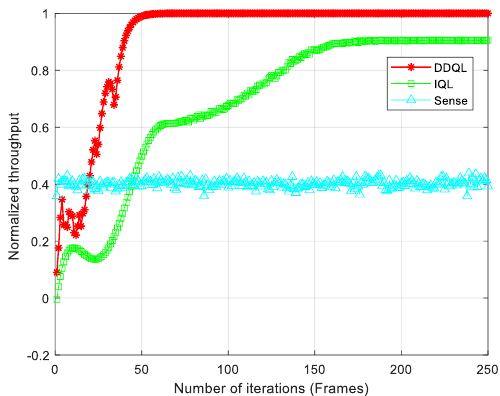
Figure 5. Relationship between normalized throughput and iteration times.